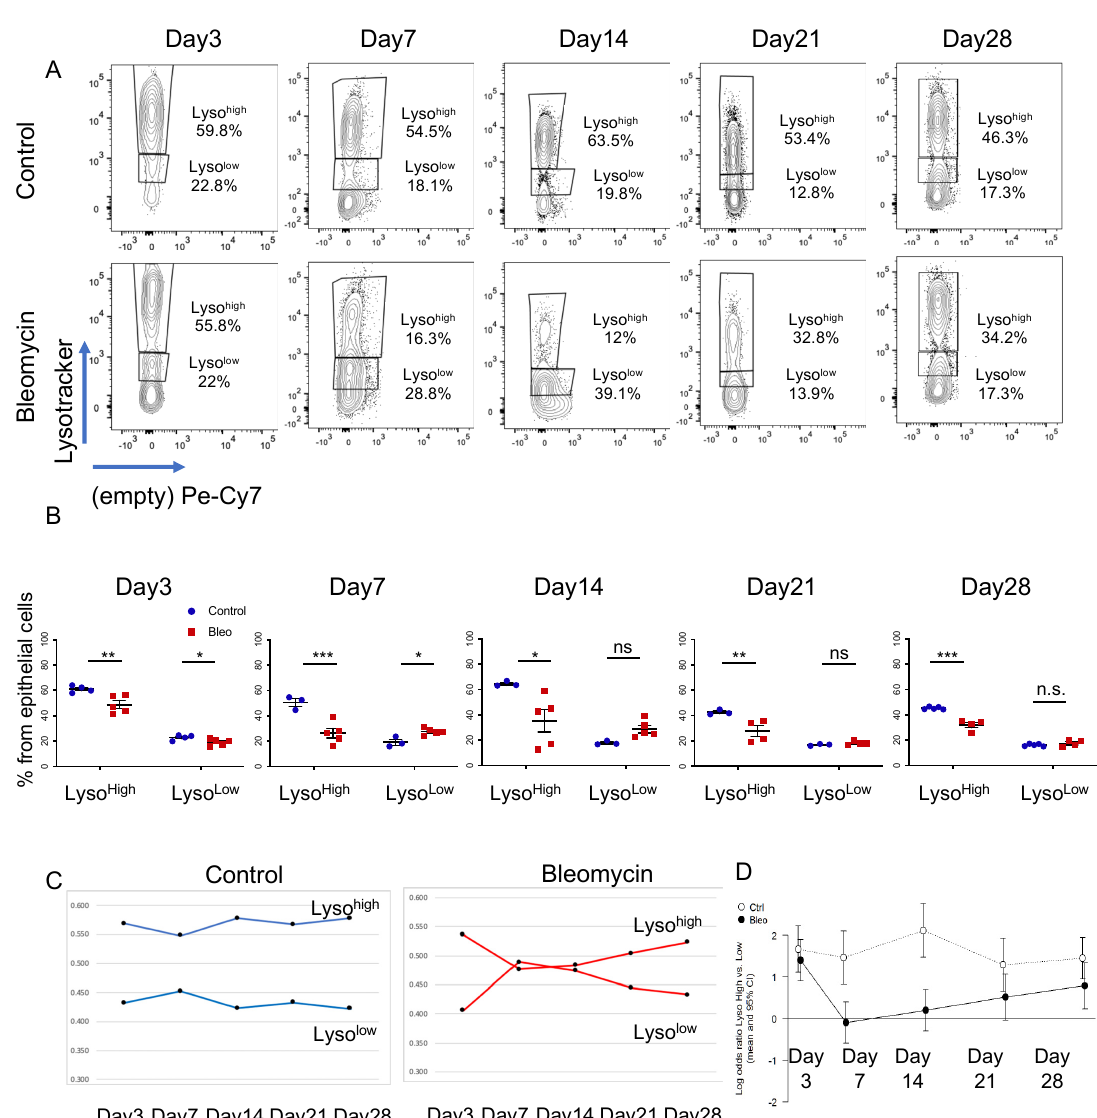
Figure 1. Characterization of AEC2s in a bleomycin model of lung fibrosis. ( A – D ) Bleomycin or saline were intratracheally instilled into the lungs of C57B6 mice, which were analyzed after 3 (control n = 4, bleomycin n = 5), 7 (control n = 3, bleomycin n = 5), 14 (control n = 3, bleomycin n = 5), 21 (control n = 3, bleomycin n = 4) and 28 (control n = 4, bleomycin n = 4) days. The flow cytometry analysis of the AEC2s in the epithelial compartment, defined as DAPI − CD45 − CD31 − PDP − EpCAM + . ( A ) Representative panels of LysoTracker uptake (Lyso high and Lyso low ) as a percentage of the parent epithelial compartment of bleomycin-treated mice. ( B ) Statistical analysis of the Lyso high and Lyso low populations at each time point. Data are presented as the means ± SEM. * p < 0.05, ** p < 0.01, *** p < 0.001, n.s. = not significant by ANOVA. ( C ) Time-course analysis of the Lyso high and Lyso low populations in control mice (left panel) and bleomycin-treated mice (right panel). ( D ) Analysis of the log odds ratio of the Lyso high vs. Lyso low population (log Lyso high /Lyso low ) during the time course of bleomycin recovery. Data are presented as the means and 95%confidence intervals.